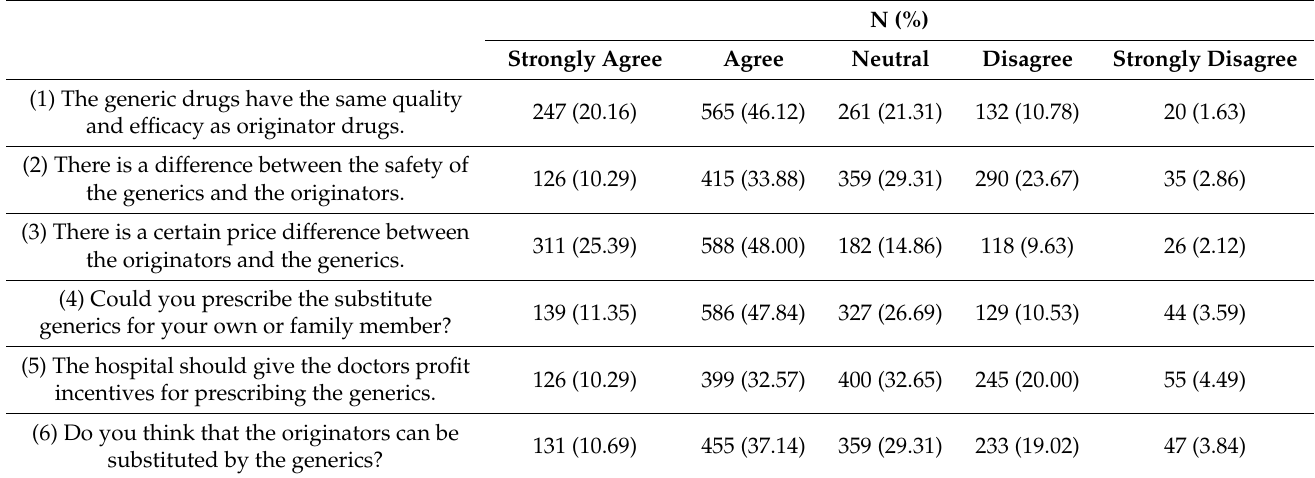
Table 4. Physician’s attitudes of statement on generic